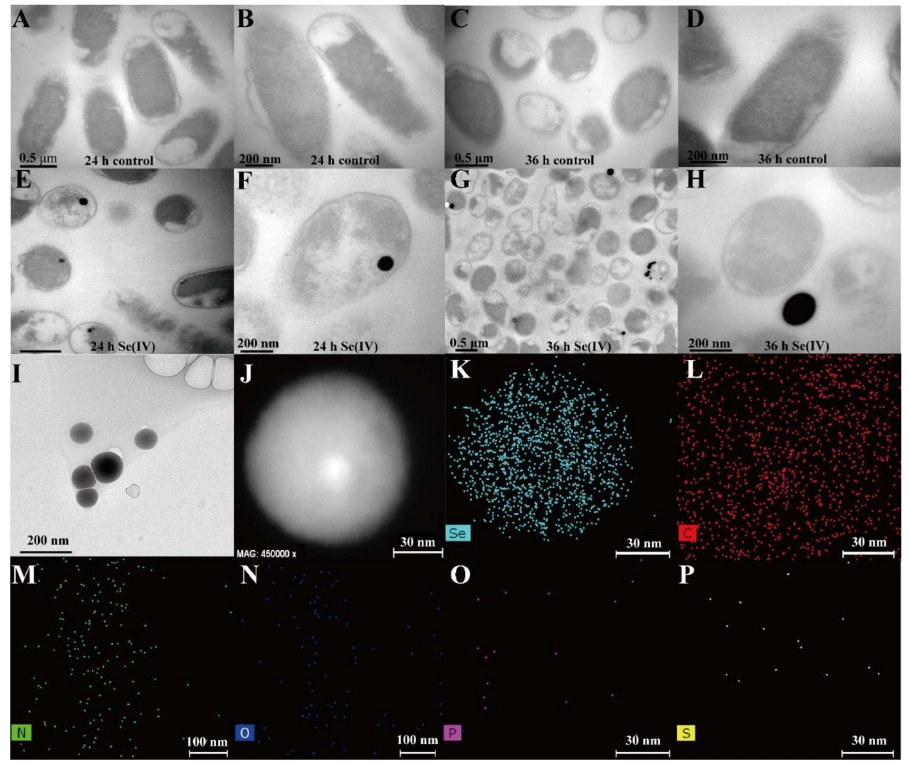
Figure 1. TEM and element mapping analysis of Bio-SeNPs. The Escherichia coli S17-1-pCT-Zori- csrF strain was cultured until OD 600 reached 0.8–1.0. Then, the cells were incubated without selenite for 24 h ( A , B ) and 36 h ( C , D ) and with selenite (1 mmol/L) for 24 h ( E , F ) and 36 h ( G , H ); The Bio-SeNPs were extracted from the cells ( I ); The HAADF ( J ) and Se, C, N, O, P and S elemental mapping ( K – P ) images of Bio-SeNPs were